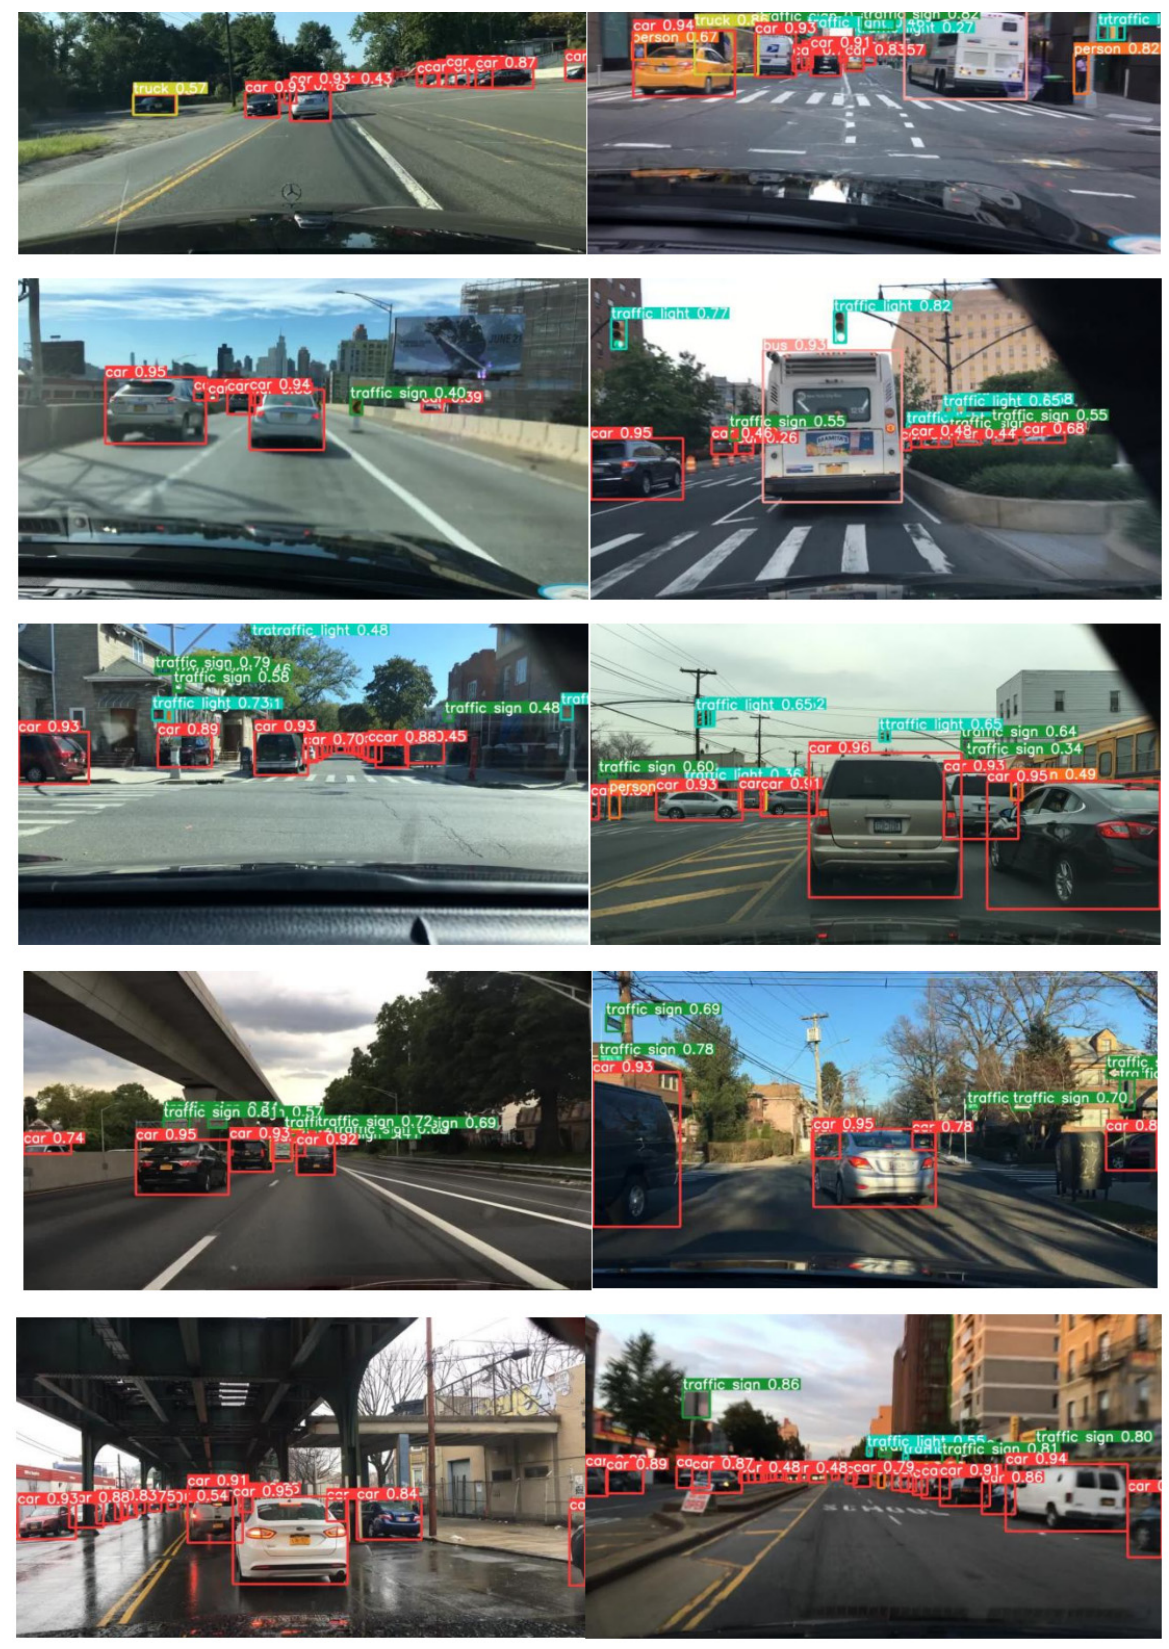
Figure 7. Results on the bdd100k dataset.